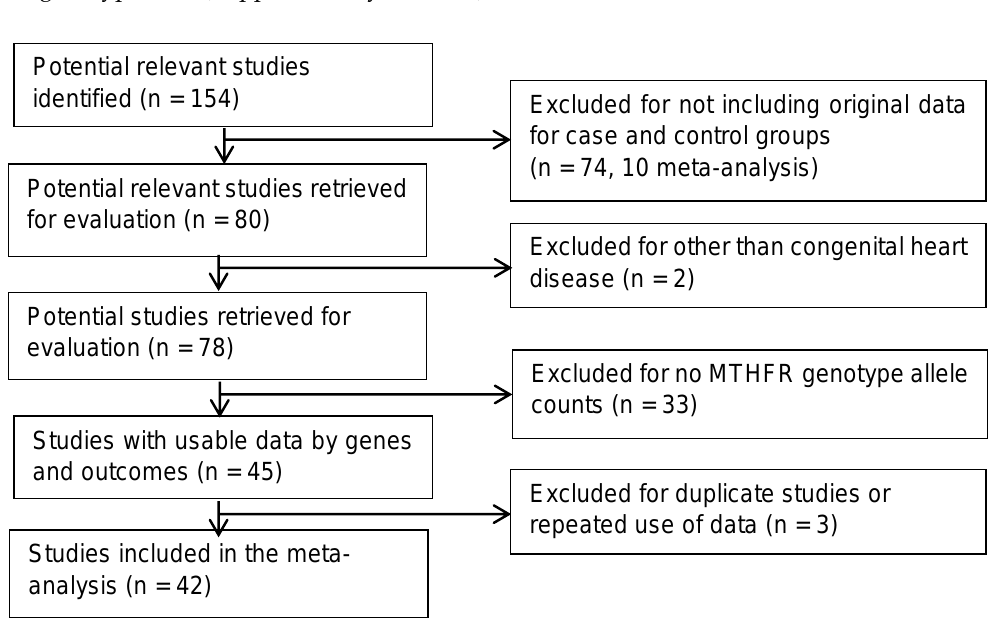
Figure 1. Progression on the selection of studies for the meta-analysis.